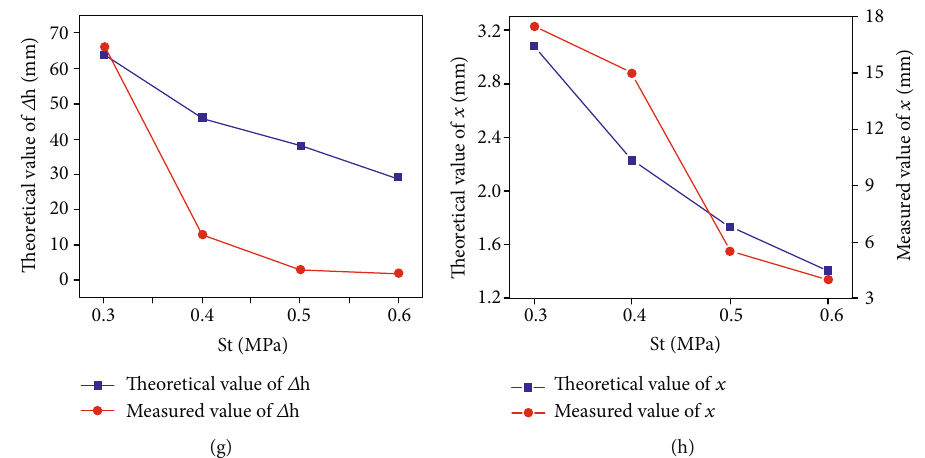
Figure 10: Theoretical and measured values of erosion pit size under di ff erent fracture parameters (Ma, H, P, St).